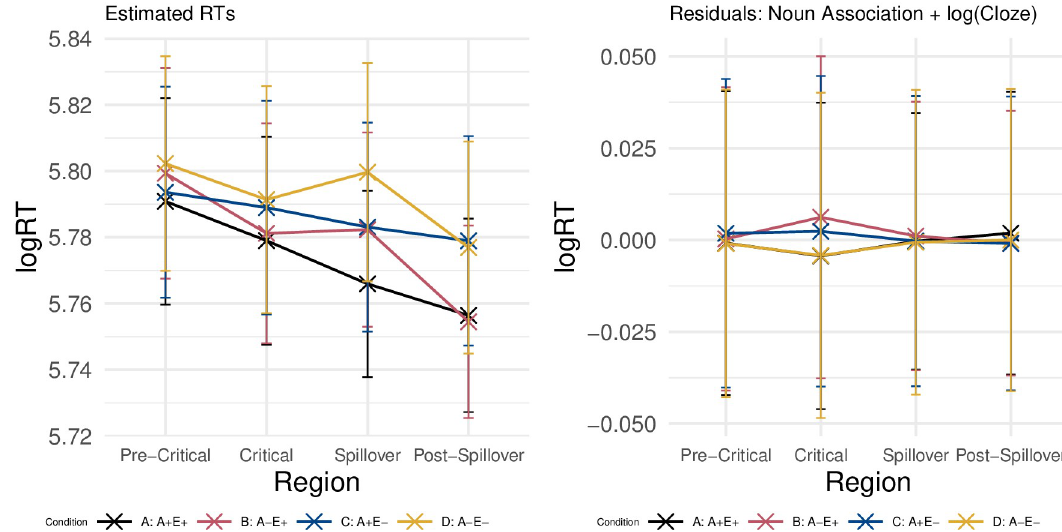
Fig 9. Estimated RTs and residual error. Estimated log-Reading Times (left) and residual error (right) per condition on the pre- critical, critical, spillover, and post-spillover region. Error bars indicate standard errors on the condition means.